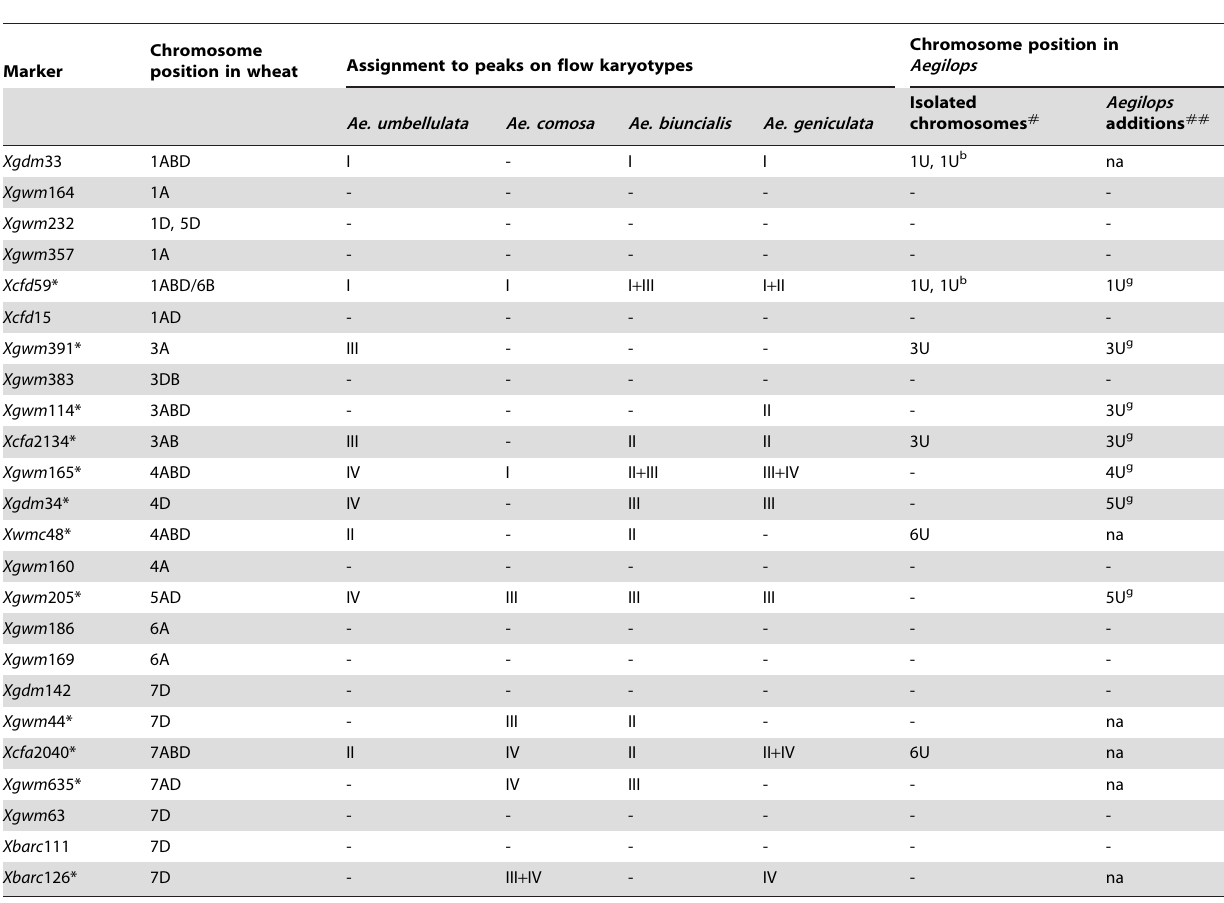
Table 1. Wheat microsatellite (SSR) markers used in the present study, their assignment to peaks I–IV on flow karyotypes of Ae. umbellulata , Ae. comosa , Ae. biuncialis and Ae. geniculata and their positions on Aegilops chromosomes.